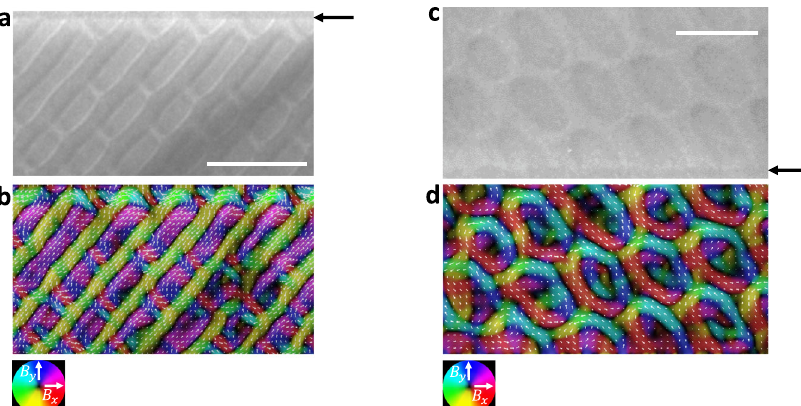
Fig. 3 Transport of intensity equation (TIE) analysis of fractional (anti)skyrmions. a LTEM image at a magnetic fi eld of − 14.5 mT and a temperature of 200 K. The boundary between Mn 1.4 Pt 0.9 Pd 0.1 Sn and PtC x is marked by black arrows. b The corresponding in-plane magnetic fi eld reconstructed by solving the TIE. The color indicates the in-plane fi eld direction according to the small white arrows. c LTEM image at − 16 mT and 125 K. d The corresponding in- plane magnetization. Both LTEM images are taken at the defocus value of ∼ 0.3 mm. LTEM images at different defocus values are shown in supplement Figs. S8 – 9. The scale bars in ( a ), ( c ) correspond to 300